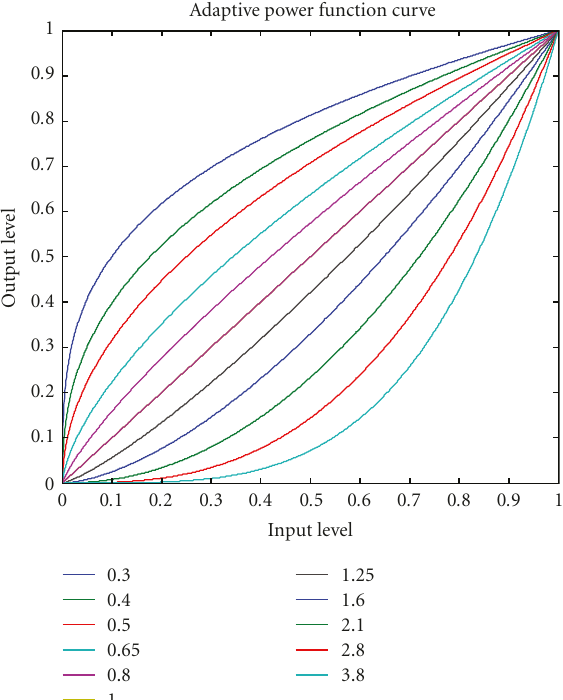
Figure 6: Gamma function curve for di ff erent γ ’s